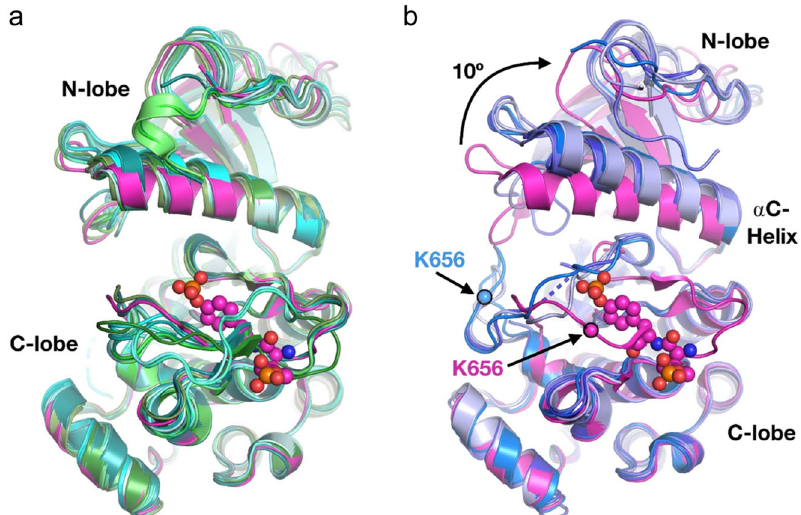
Fig. 6 FGFR structural analysis. a Comparison of FGFR2 and FGFR3 kinase domain structures bearing N549H/T, K659E/N/M/Q/T, K650E, or K656E activating mutations (shades of green/teal) with wild-type FGFR1 in the active conformation (magenta). Autophosphorylated Tyr residues in the activation loop are shown in spheres. All mutant crystal structures were determined in the apo state or in the presence of an ATP analog (ball-and-stick model shown in center). Superimposed structures are from Protein Data Bank (PDB) entries 3GQI, 4K33, 2PWL, 5UHN, 2PZ5, 4J97, 5EG3, 4J98, 2PVY, 4J95, 4J99, 4J96, and 5UI0. b Comparison of four inhibitor-bound FGFR1 structures (shades of blue) with the structure of FGFR1 in the active conformation (magenta). In the inhibitor-bound structures, a ~10° rotation in the N-lobe was observed compared with its orientation in the active state, consistent with the inhibitor-bound structures being in the inactive, “ open ” conformation. The common site of mutation K656 in the activation loop also changes conformation in the inhibitor-bound structures. All structures are aligned to the C-lobe of the kinase. PDBs 3GQI, 4V05, 3TT0, 4TYI, and